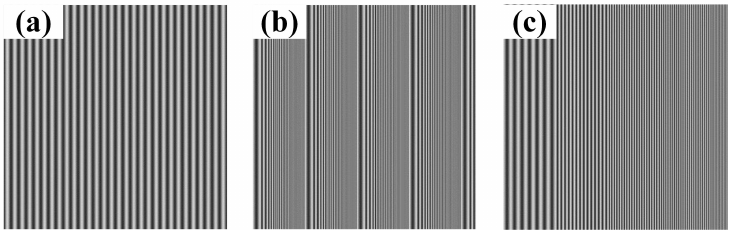
Figure 8. The computer-generated pattern: ( a ) sinusoidal fringe pattern with initial phase of − π ; ( b ) coded fringe pattern VF1; ( c ) coded fringe pattern VF2.